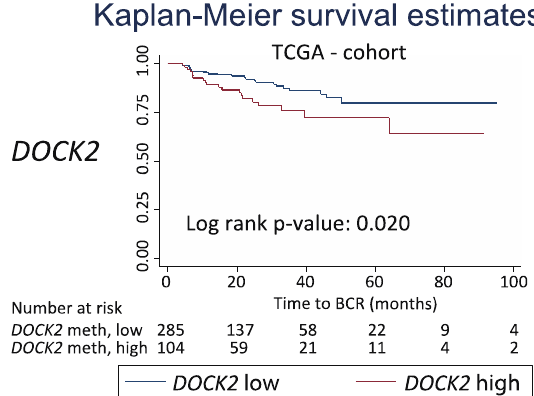
Figure 7. External validation of prognostic potential of DOCK2 hypermethylation in The Cancer Genome Atlas (TCGA) cohort. Kaplan–Meyer plots with biochemical recurrence (BCR) as an endpoint. Division of patients into low and high methylation groups was based on the ROC curve analysis of the BCR status at 36 months after RP. P-value from the log-rank